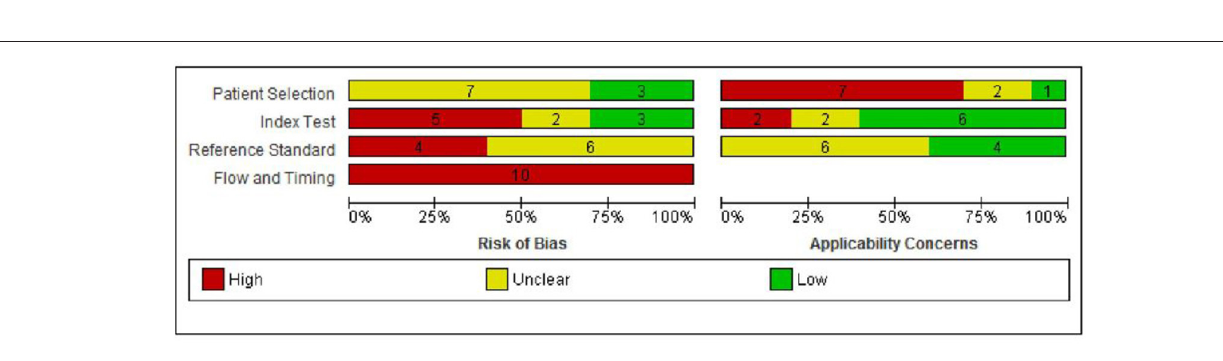
FIGURE 2 | Risk of bias and applicability concern graph: review authors’ judgments about each domain presented as percentages across included